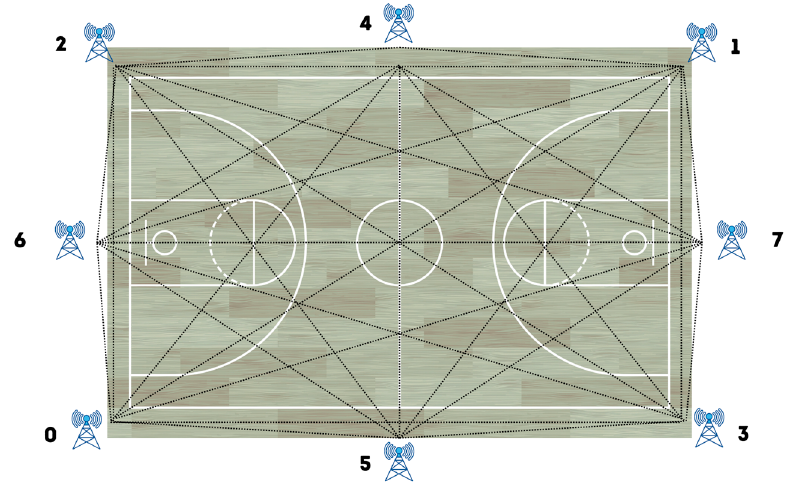
Figure 2. System of UWB antennas on a basketball court.